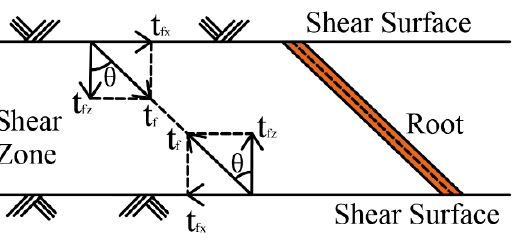
Figure 1. Schematic diagram of Wu’s model (Modi fi ed from Wu et al. [31]).